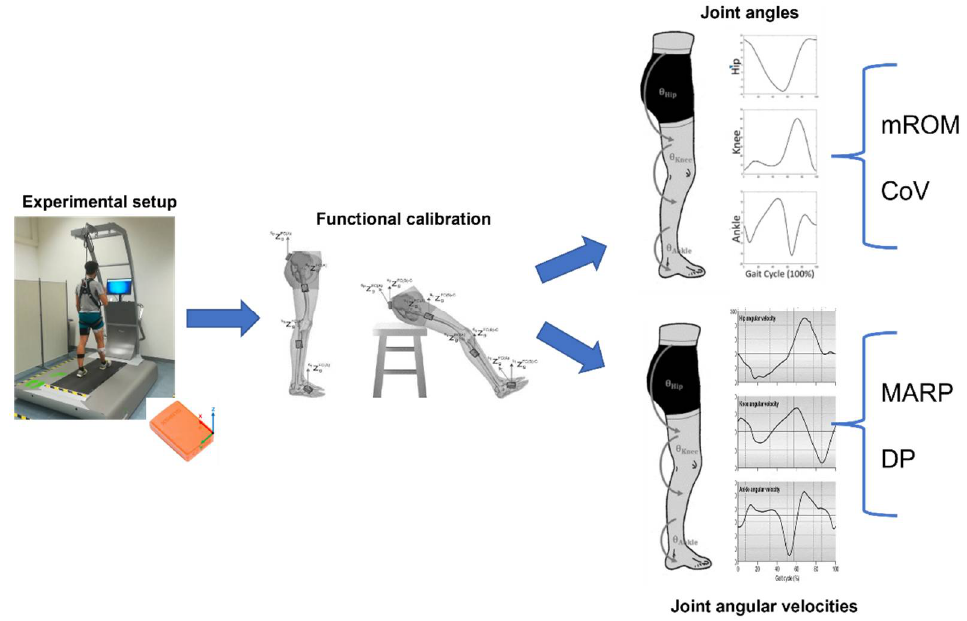
Figure 2. Schematic summary of experimental setup, data processing, and analysis.